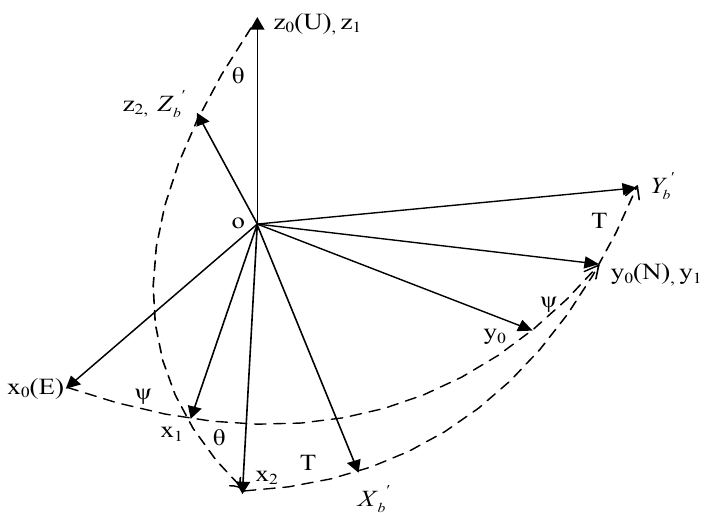
Figure 5. The process of coordinate